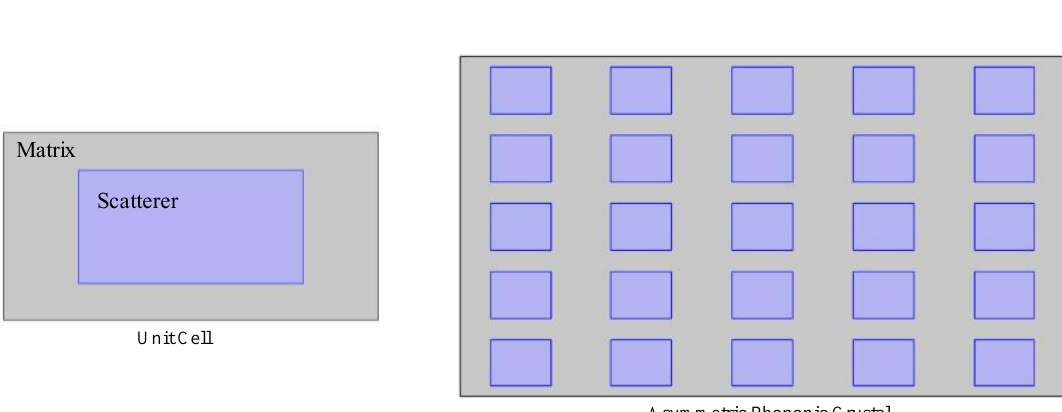
Figure 2. Asymmetric Bragg’s scattering Phononic crystal with unit cell. The lattice constant is different in horizontal and the vertical directions making the structure